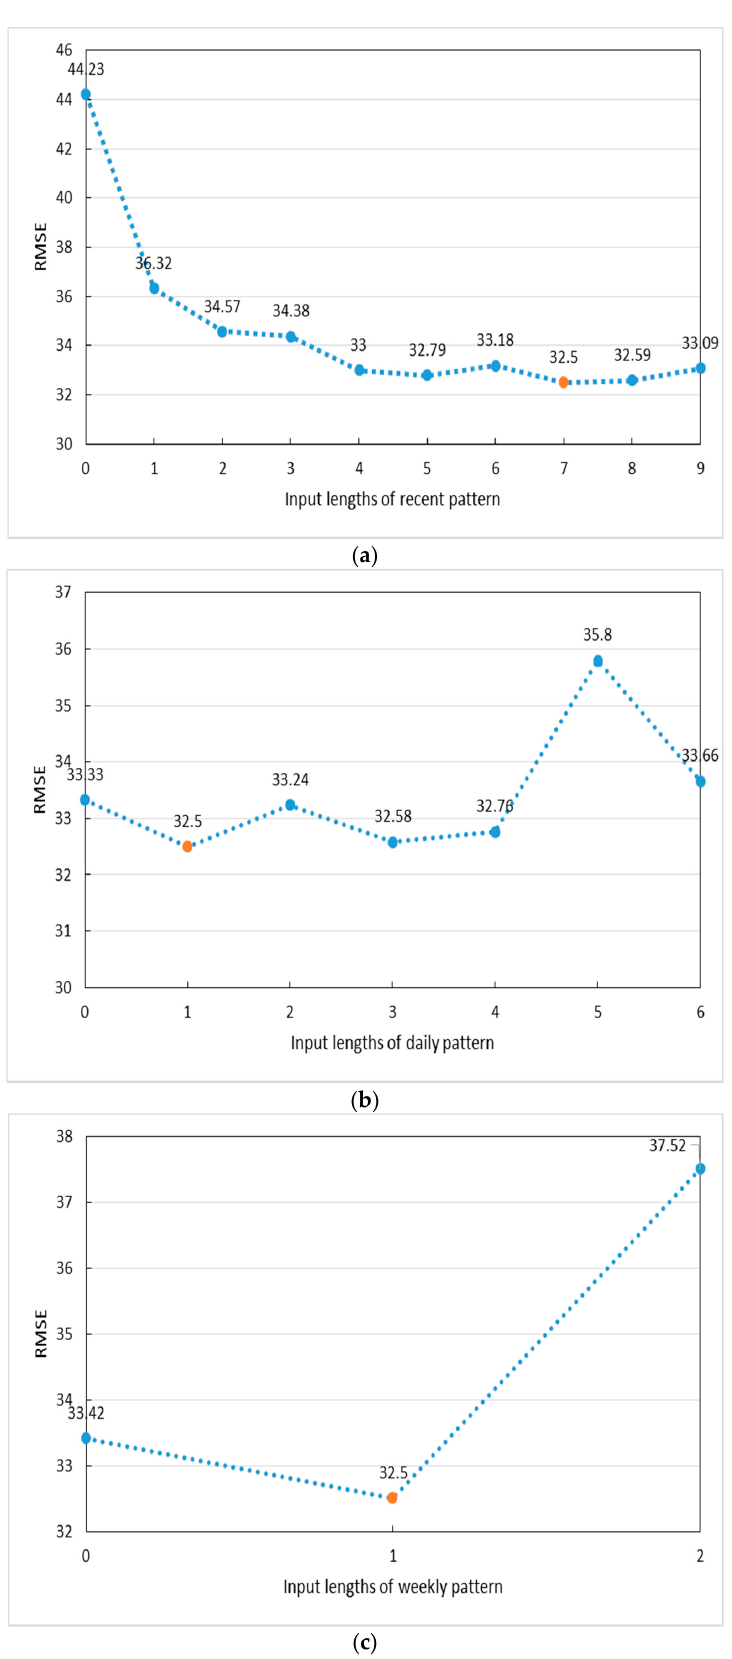
Figure 11. Experimental results for di ff erent input lengths of ( a ) the recent pattern, ( b ) the daily pattern, and ( c ) the weekly pattern. RMSE: Root-mean-square